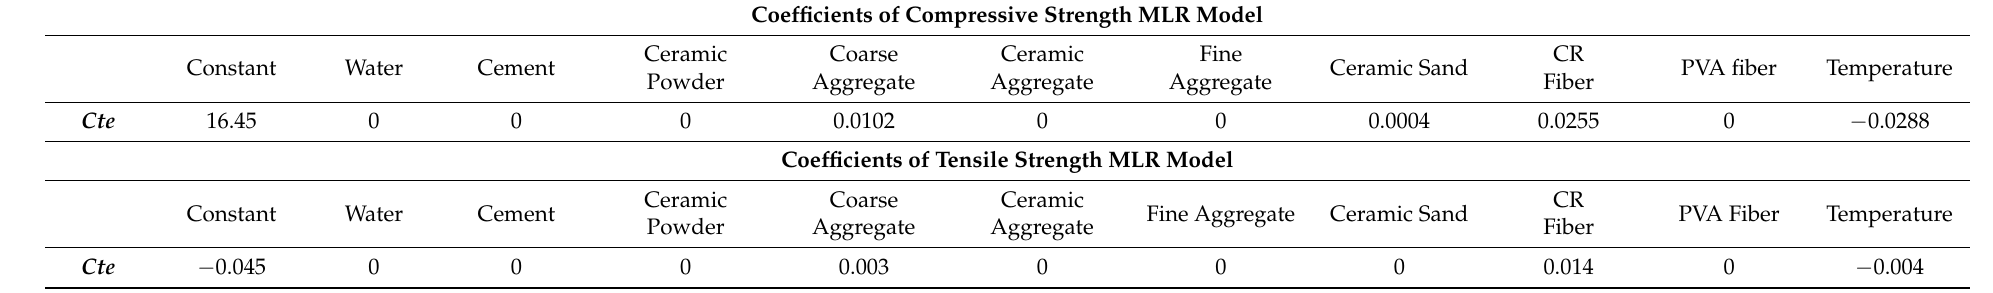
Table 10. Coefficients of MLR